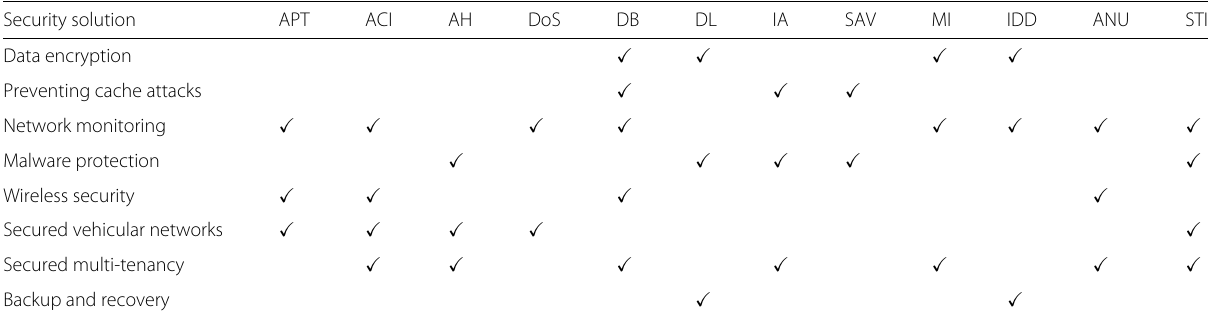
Table 3 Security solutions that can resolve twelve potential security issues in Fog implementations Security solution Data